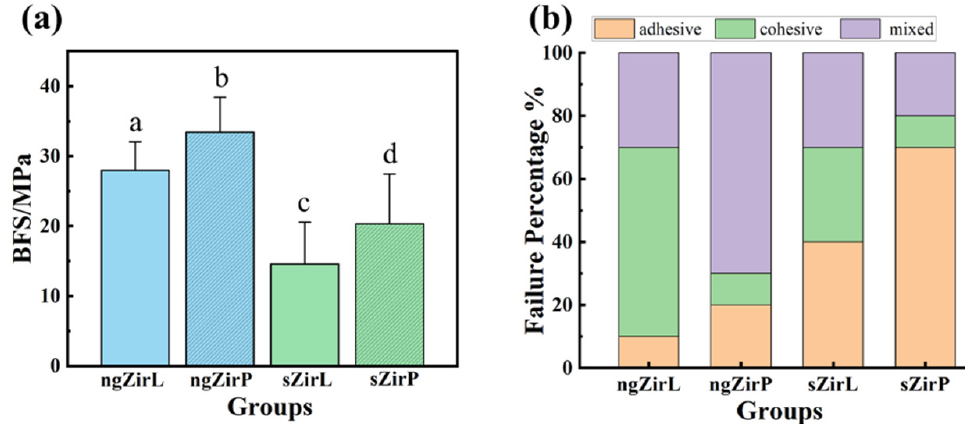
Figure 6. The SBS values ( a ) and failure mode ( b ) of different groups.